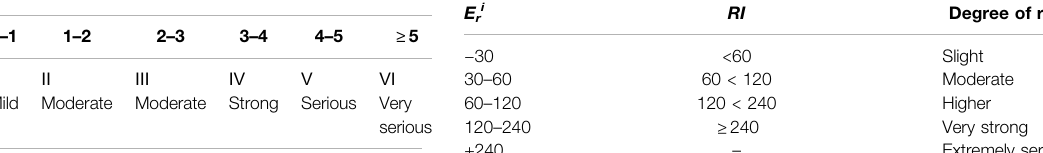
TABLE 1 | The system for evaluating the degree of heavy metal pollution based on I